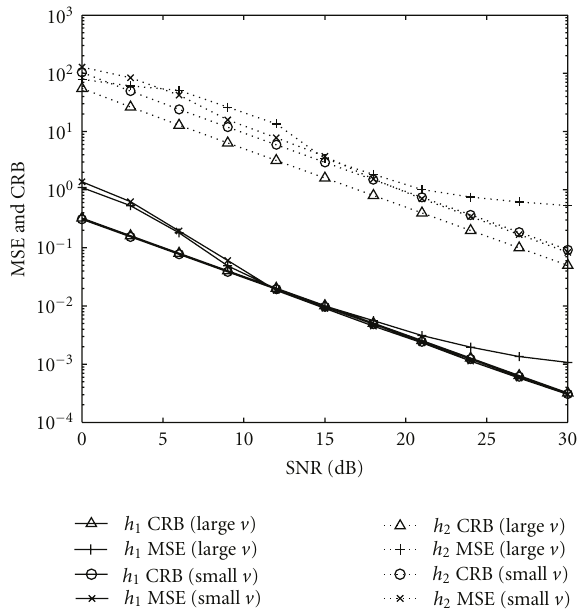
Figure 7: Channel estimation MSE versus SNR: N =